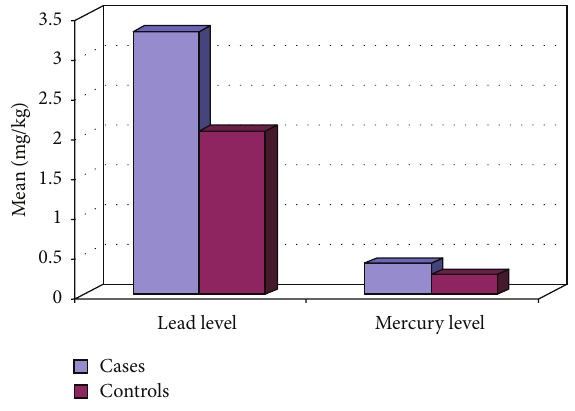
Figure 2: Mean lead and mercury levels in hair in both groups.